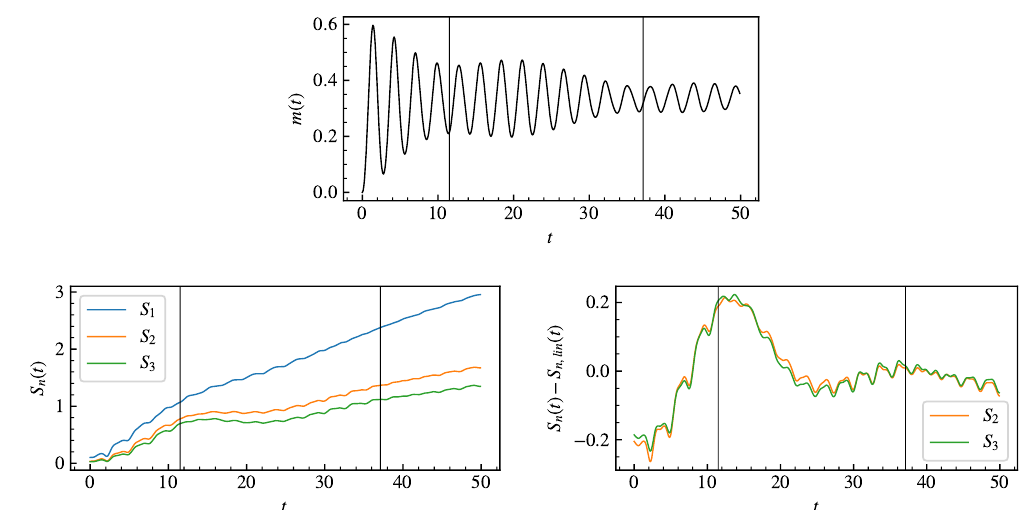
Figure 4.4: Time evolution of various quantities after a large quench ( g ) = ( 2.0,0.0 ) → ( g , h ) = ( 2.0,1.4 ) in the quantum Potts spin chain. The , h 0 0 top left diagram shows the evolution of magnetisation, the top right one the von Neumann entropy ( S ) and two of the Rényi entropies ( S 1 one shows the entropy evolution with the linear trend subtracted. The vertical lines correspond to a single period of the slow oscillation corresponding to the frequency − m 2 m . The first line is drawn at the first minimum of the envelope of the magneti- 1 2 sation oscillations while second is drawn at a distance given by the period T ≈ 25.6. Note that their position matches quite well the behaviour of the entropy curves as well. Time is measured in units of 1 / J , and the initial entropy was